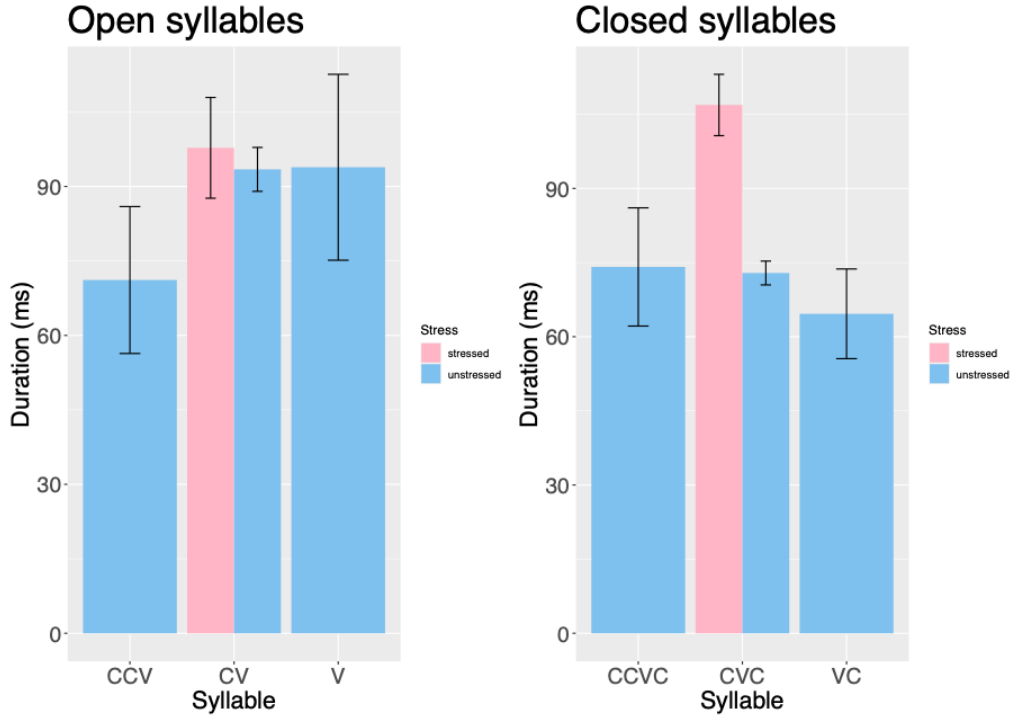
Figure 7. Data subsets showing mean vowel duration values (milliseconds) for open sylla- bles (left panel) vs closed syllables (right